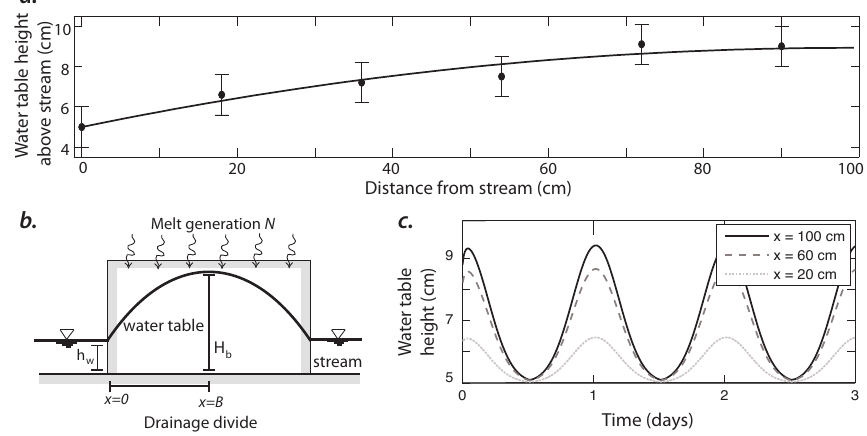
Fig. 4. (a) Water table height measurements as a function of distance away from a stream, with nonlinear fit of Eqs. (3) and (4), assuming n 0 = 0 . 01mh − 1 and peak melting, B = 1m, h w = 0 . 05m, φ = 0 . 1 and k = 1 × 10 − 11 m 2 . Error bars are 1cm. (b) Sketch of the model problem and geometry, illustrating the Dupuit–Forchheimer ellipse. (c) Variation of water table height h(x,t) from numerical solution to Eq. (3) parameters as in panel (a) . Curves plot points along the profile as a function of